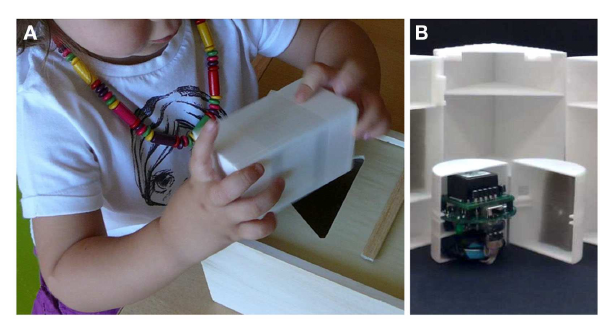
FIGURE 1 | Instrumented sorting block toy .The traditional sorting block is a relatively complex toy for young children, which ultimately requires good spatial orientation, grasp control, force control, and motion planning. In this instrumented version of the toy, the block has been equipped with an inertial measuring unit (B) to track and record the object’s orientation and linear accelerations during grasping, manipulation, and reaching tasks (A)